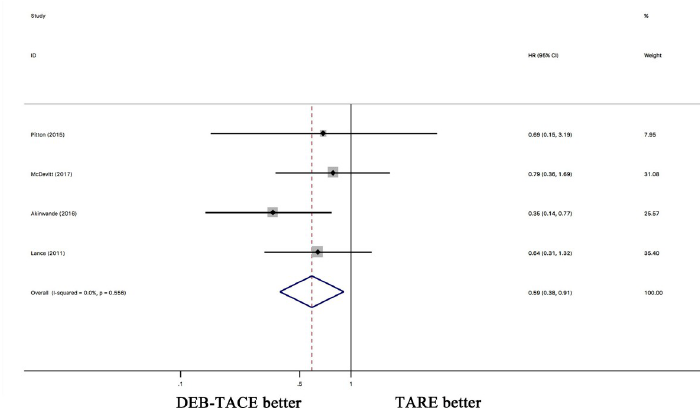
Fig 4. The pooled HRs for OS between DEB-TACE and TARE for hepatocellular carcinoma.